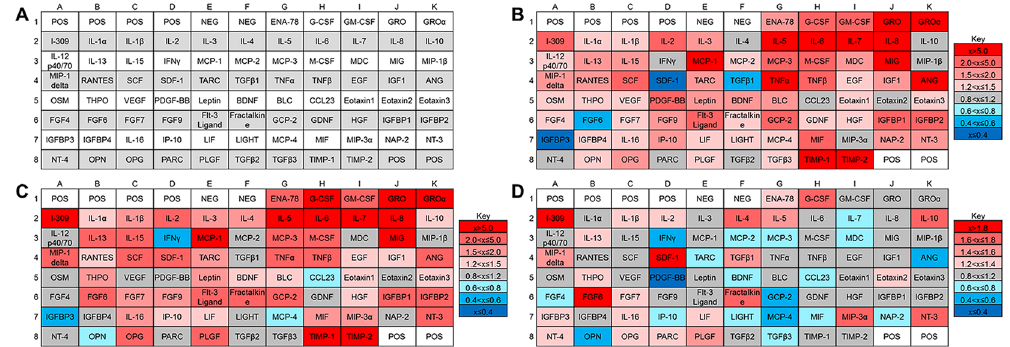
Figure 2. HUVECs and DRGs secreted a variety of proteins. ( A ) Map of cytokine array used to determine protein secretion from ( B ) HUVEC monocultures and ( C ) DRG-HUVEC co-cultures normalized to EGM-2 medium. To determine how the DRG population affected the secretion and consumption of proteins, ( D ) results from arrays assayed with DRG-HUVEC co-cultures were normalized to HUVEC monocultures. In all cases, red indicates overexpression of indicated proteins and blue indicates underexpression of indicated proteins, with gradations of each color indicating relative amount of over/under expression. POS and NEG wells are internal controls within the cytokine array assay. Data are compiled from two independent